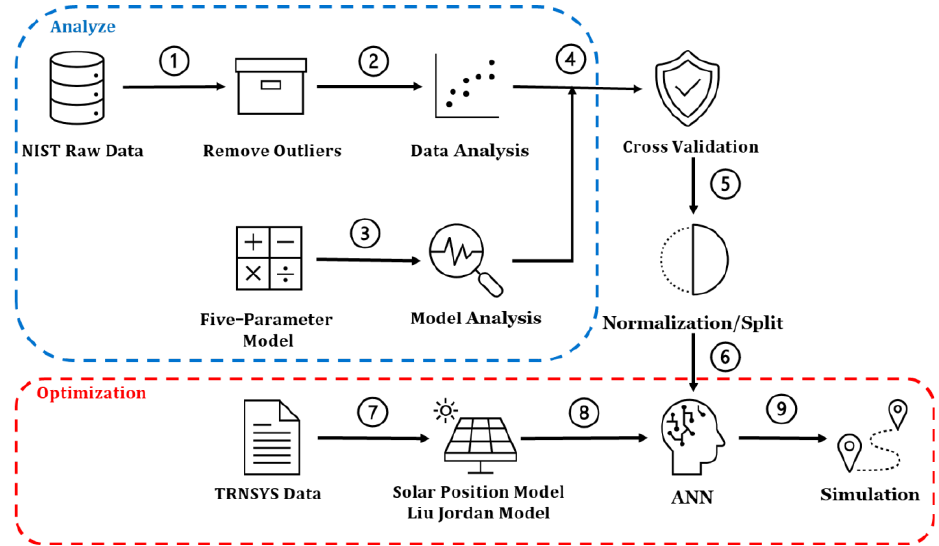
Figure 2. Flow chart of the proposed